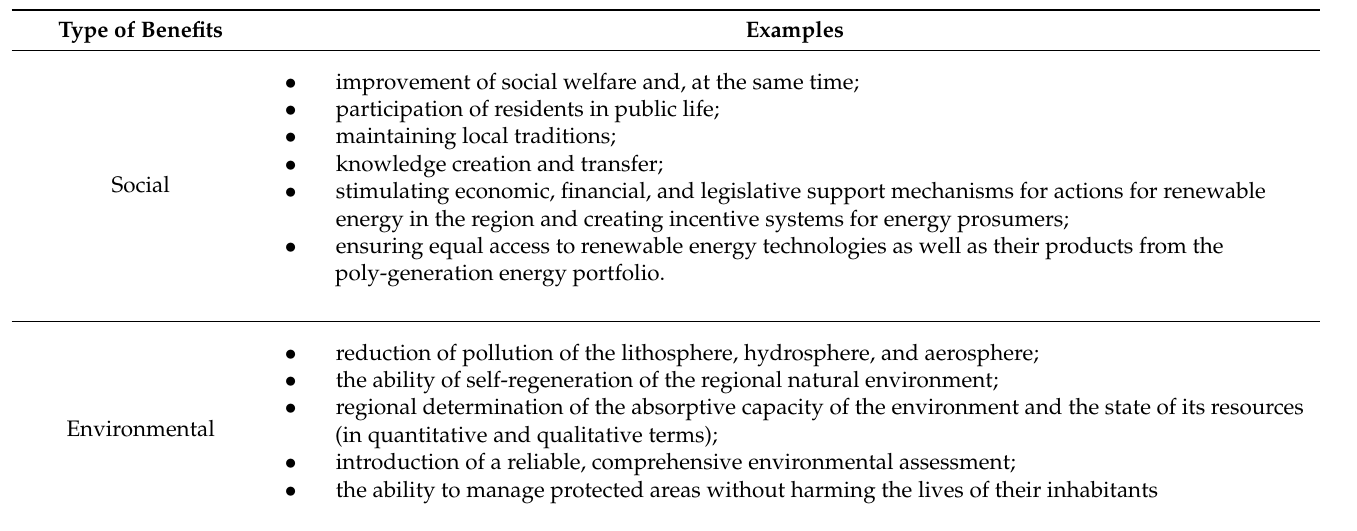
Table 4. Social and environmental benefits of renewable energy